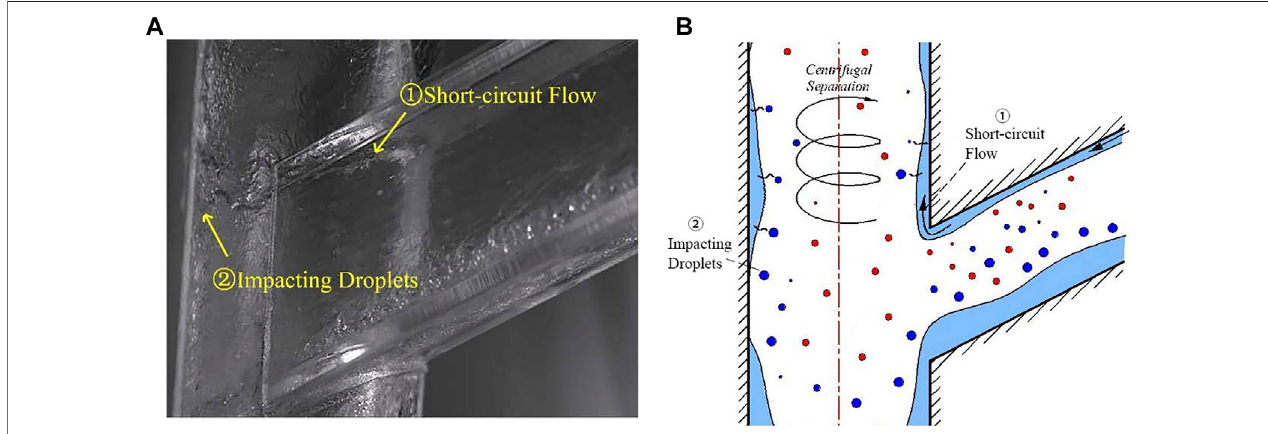
FIGURE 2 | Illustration (A) and the schematic diagram (B) of USLF Formation in GLCC: (1) Direct short-circuit fl ow from the inlet; (2) Droplets impacting due to centrifugal